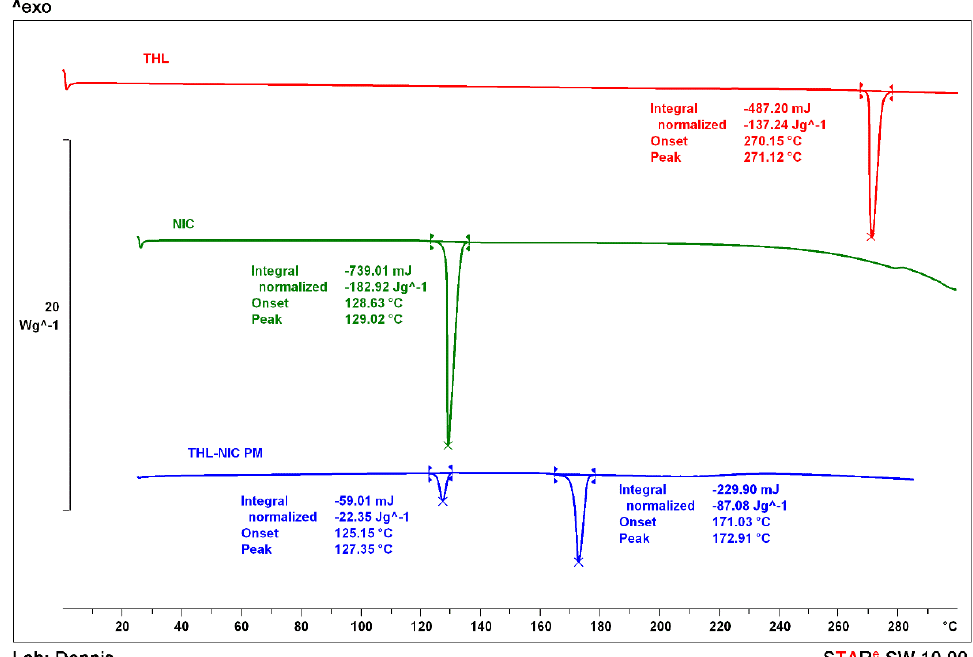
Figure 4. Differential scanning calorimetry (DSC) thermograms of bulk THL, bulk NIC and the THL-NIC physical mixture .